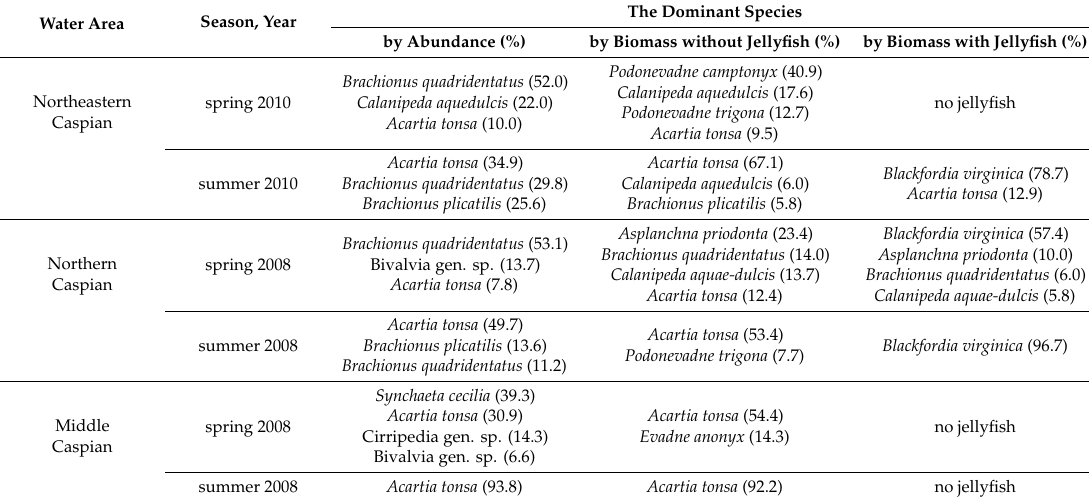
Table 4. Composition of the dominant species in zooplankton communities in the surveyed water area of the Caspian